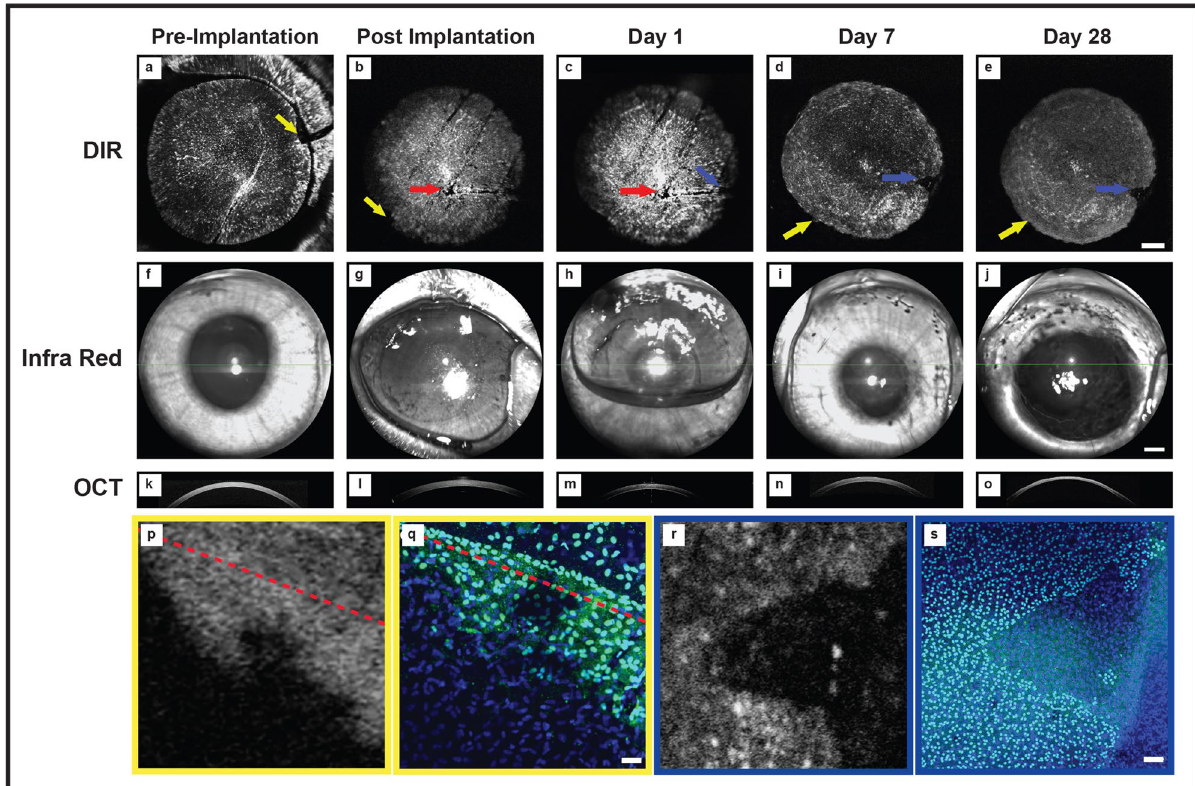
Figure 9. Tracking of transplanted human corneal endothelial cells in vivo. ( a ) A DIR stained DMEK graft imaged in the viewing chamber pre-implantation. A triangular notch is cut out the circular graft and used to confirm the correct side is up during surgery (yellow arrow). ( b ) The same graft is imaged immediately after surgery. Linear, parallel wounds associated with graft insertion can be seen following DMEK (red arrow) as can the notch in the transplanted graft (yellow arrow). ( c – e ) The graft is repeatedly imaged over 28 days. Central areas, previously devoid of cells, become DIR positive suggesting cells migration over DM has occurred (red arrow). The triangular notch fades suggesting cells have migrated off the graft and onto the rabbit DM at this point (yellow arrow). Areas in the periphery of the graft are not DIR fluorescent, suggesting they are devoid of human endothelial cells. ( f – j ) Images of the rabbit eye show at the time of imaging show that DIR fluorescence is detectable when the anterior chamber contains air ( g , h ) and that cornea clarity is restored once a stable endothelial monolayer has been established ( i , j ). OCT images of cornea at various time points following transplantation ( k – o ). Scale bar ( a – j ): 1 mm. ( p ) The triangular notch shows created for orientation identification shows a loss of the straight edge (red dashed line) with apparent migration of endothelial cells off the graft. ( q ) Images of the same area are acquired after staining with human nuclear antibody (FITC). The presence of human endothelial cells beyond the border of the DMEK graft (red dashed line) is confirmed. Scale bar: 250 µm. ( r ) Areas that do not stain with DIR are seen in the graft periphery. ( s ) Cells staining positively with DAPI, but not staining with anti-human nuclear antibody (FITC) can be seen, suggesting these cells are of rabbit origin and that transfer of fluorescence between cells does not occur. Scale bar: 250